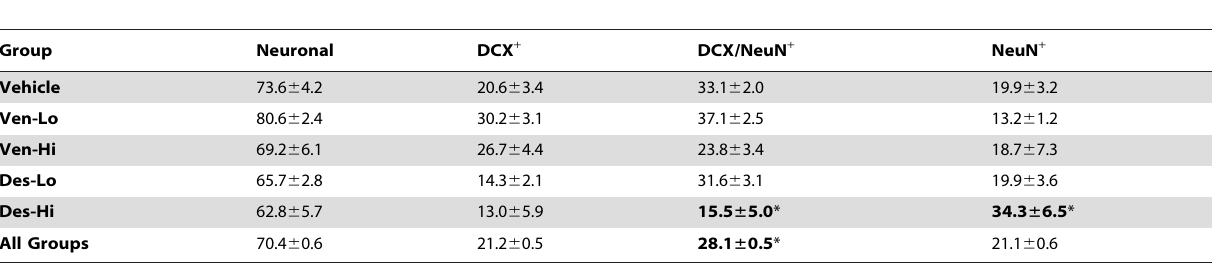
Table 1. Antidepressant Treatment Impacts The % BrdU + Cells Expressing Neuronal Markers.